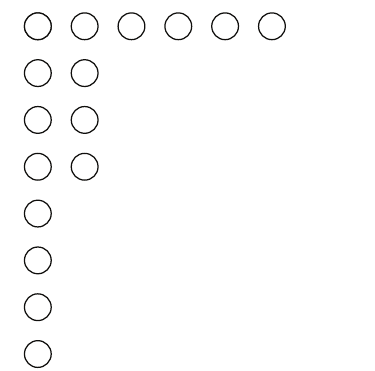
Figure 3: Ferrers diagram for the partition (8 4 1 1 1 1).